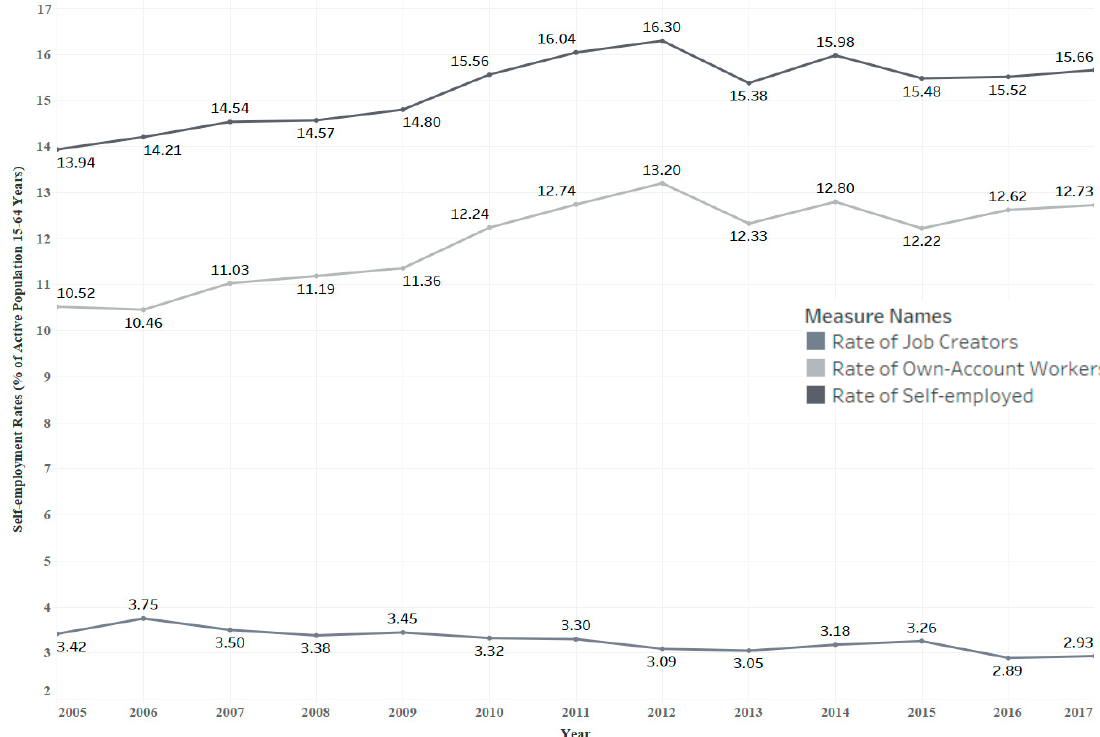
Figure 1. Development of Entrepreneurial Activity in the Czech Republic during the period 2005–2017 (Entrepreneurial Activity is calculated as % of population aged 15–64). Source: Own elaboration based on Eurostat [78–80] data.